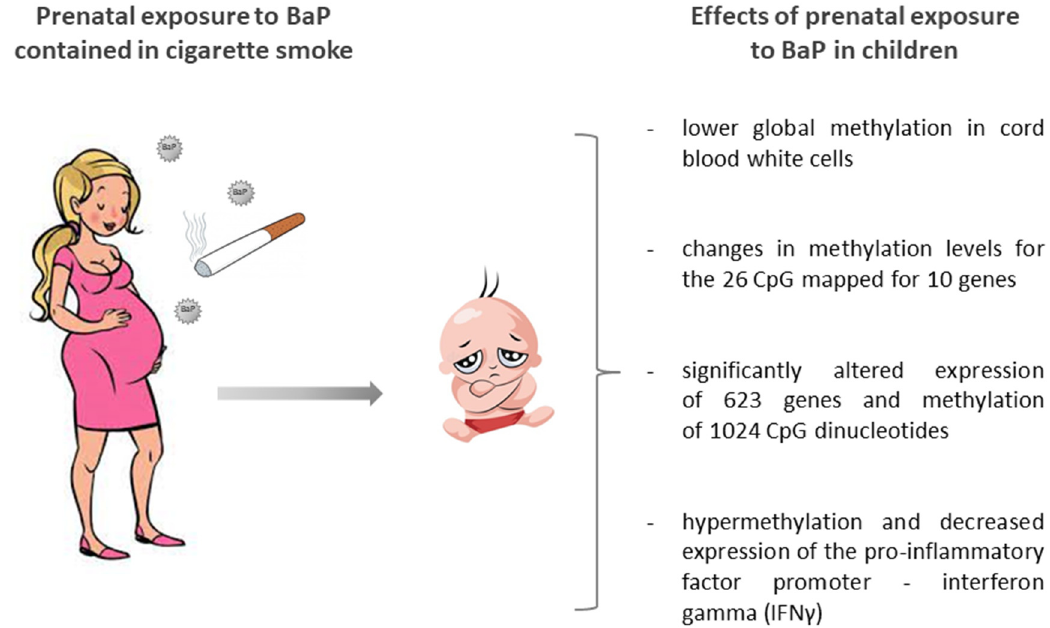
Figure 4. Prenatal exposure to PAHs and BaP and changes in methylation levels [50–52,58].